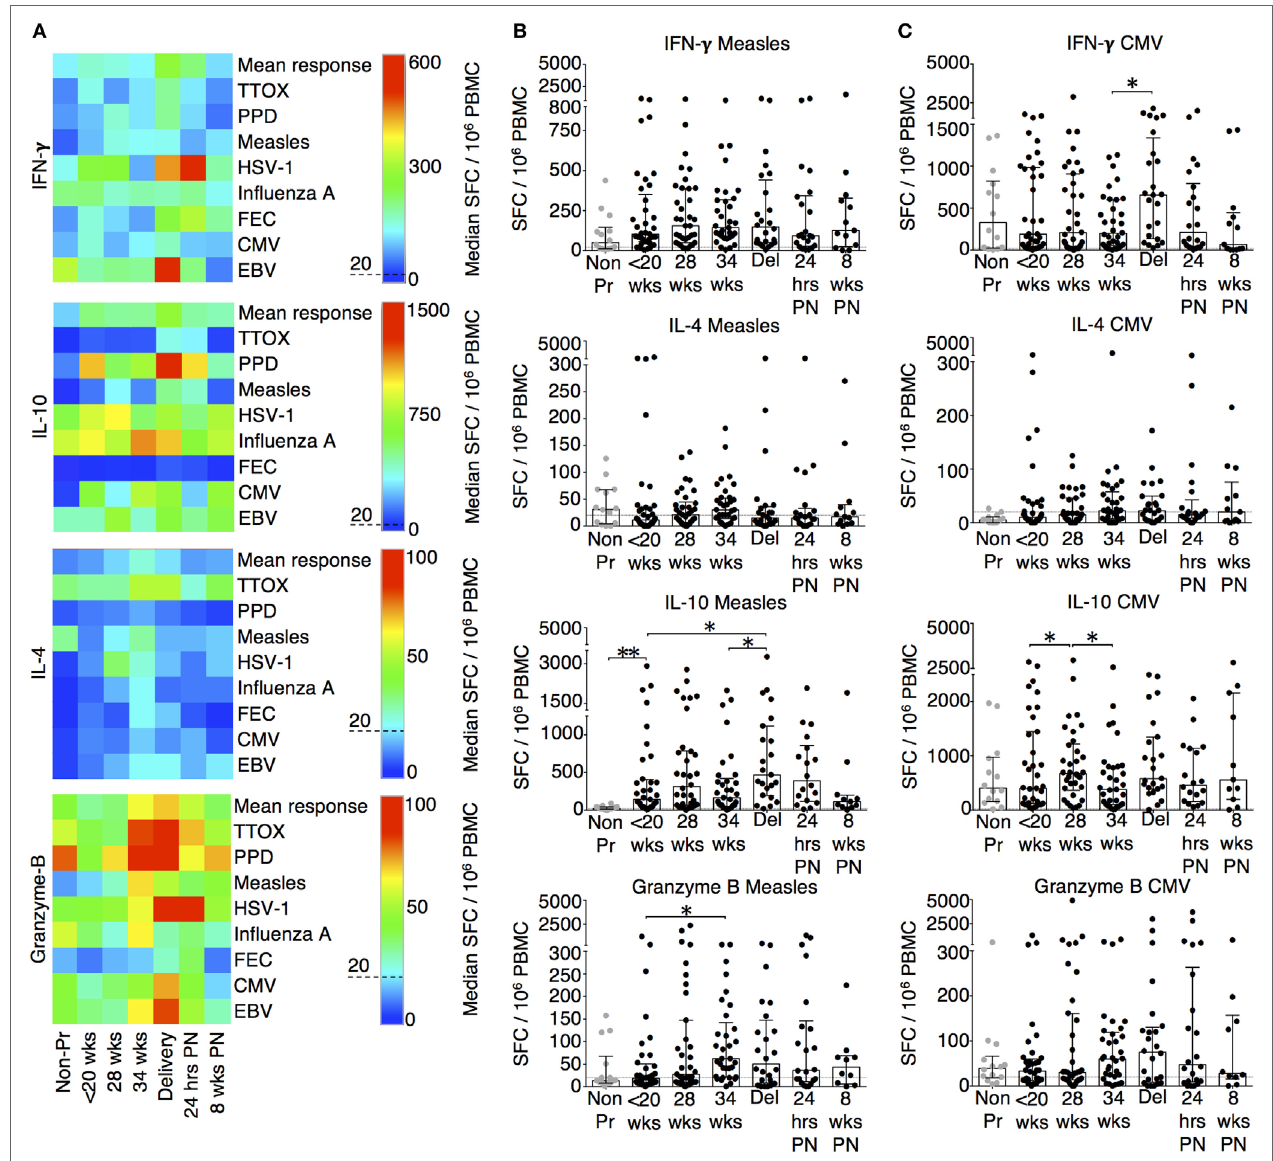
FigUre 1 | Advancing pregnancy is associated with greater IFN- γ , IL-10, IL-4, and granzyme B ELISpot responses. (a) Summary heat-map of gestation specific median ELISpot responses to antigens/peptides as well as overall mean response for each analyte. The individual scales used for each cytokine is shown with the threshold of 20 spot forming cells (SFC)/10 6 PBMC indicated using a dashed line. The heat-map was generated and analyzed using SPICE (30). (B) ELISpot responses to measles and (c) CMV whole lysates. Columns indicate median and interquartile range. Gestation at sampling is indicated in pregnancy ( ⚫ ): < 20 + 0 weeks ( N = 42 ), 28 weeks ( N = 35 ), 34 weeks ( N = 33 ), at delivery ( N = 24 ), 24 h post-delivery ( N = 22 ), 6–8 weeks postnatal ( N = 13 ). Non-pregnant controls are depicted as ⚫ ( N = 14 ). A dashed line represents < 20 SFC/10 6 . P values are two tailed and significance is defined as * P < 0.05 and ** P < 0.01. Non-pregnant and baseline pregnant data analyzed by Mann–Whitney U test. Longitudinal data analyzed by generalized linear mixed effects model with gamma log-link and pairwise multiple comparisons of estimated marginal means with sequential Bonferroni